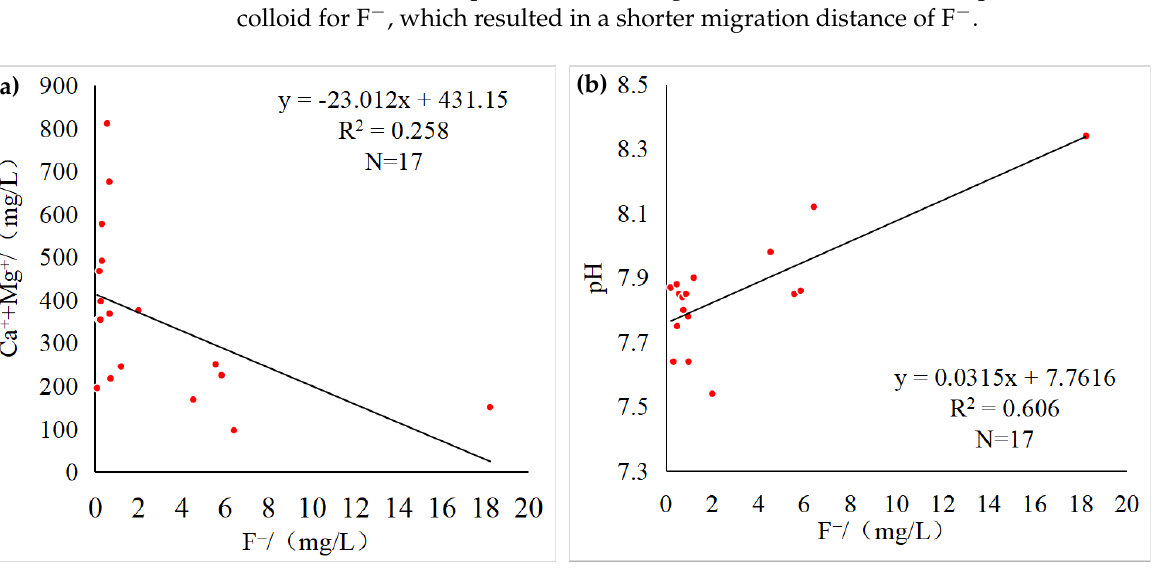
Figure 11. ( a ) Ca 2+ +Mg 2+ and F − correlation coefficient diagram; ( b ) pH and F − correlation coefficient diagram.